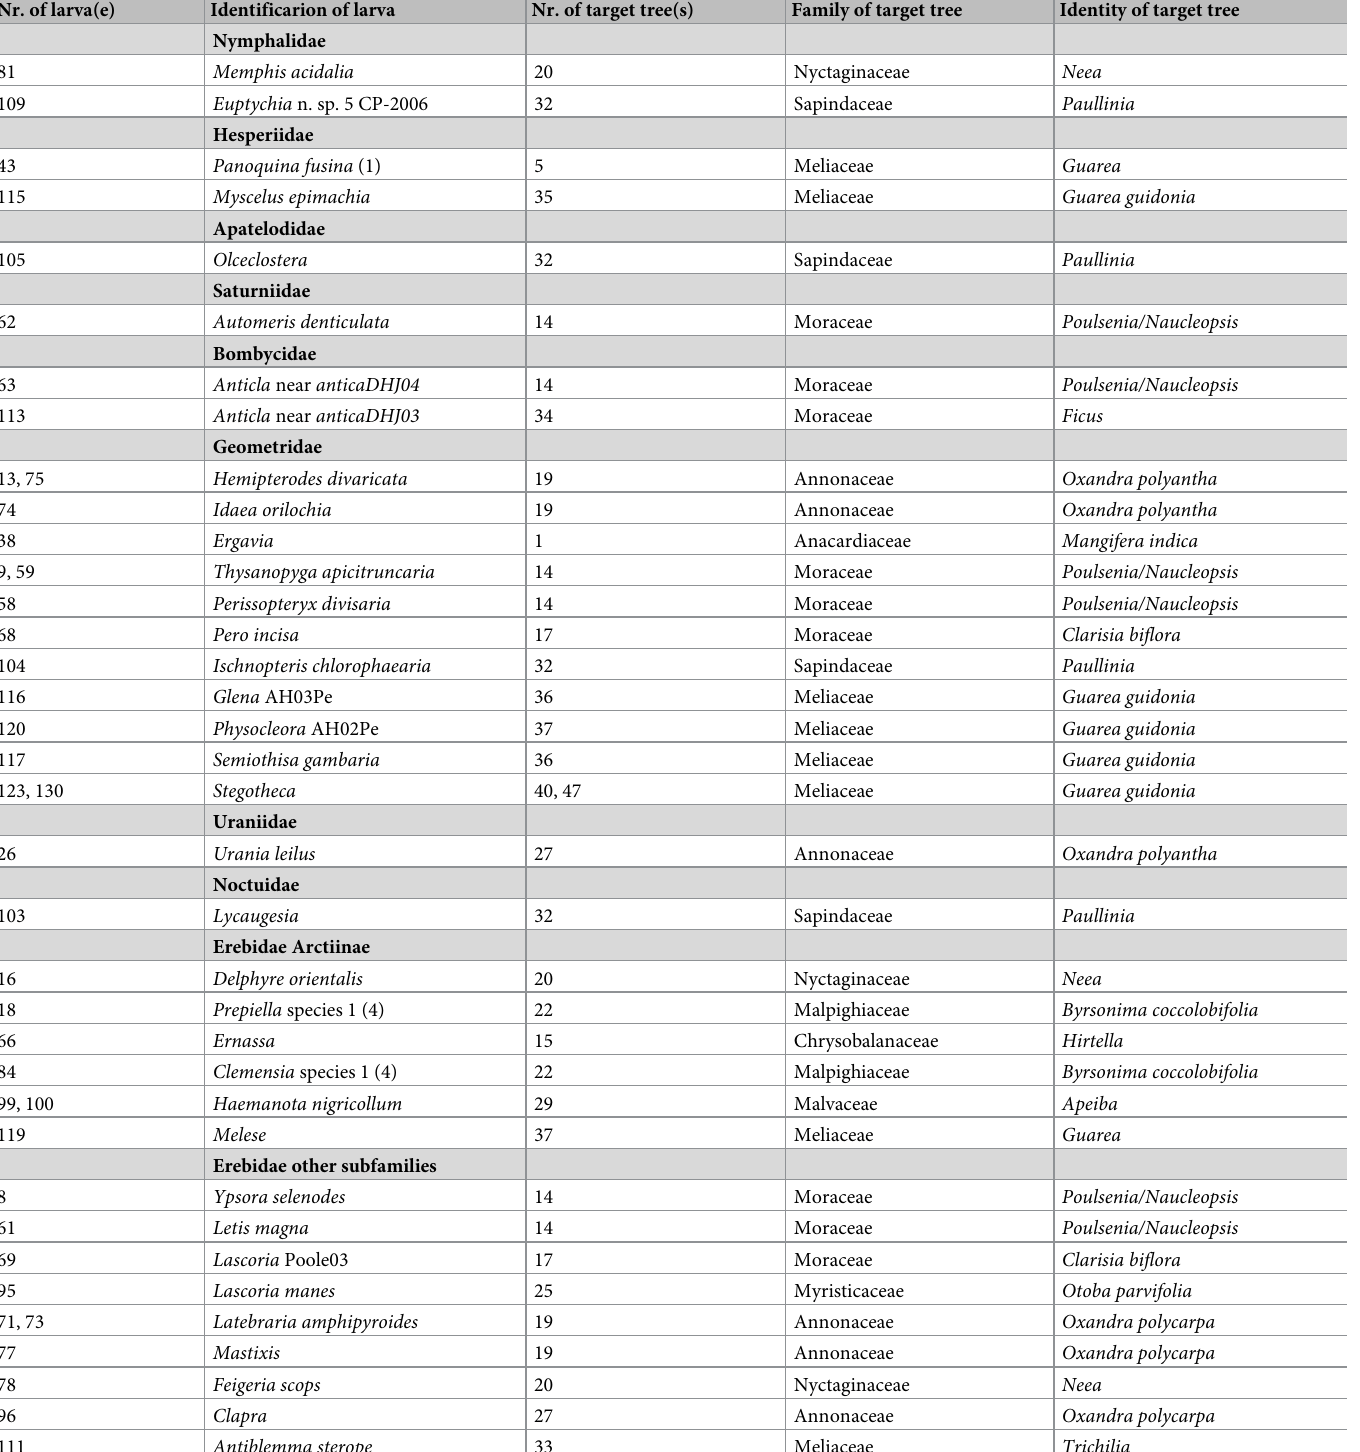
Table 5. Potential host-plant relationships for 43 larvae identified to at least genus level and identity of the fogged target tree. Nr. of